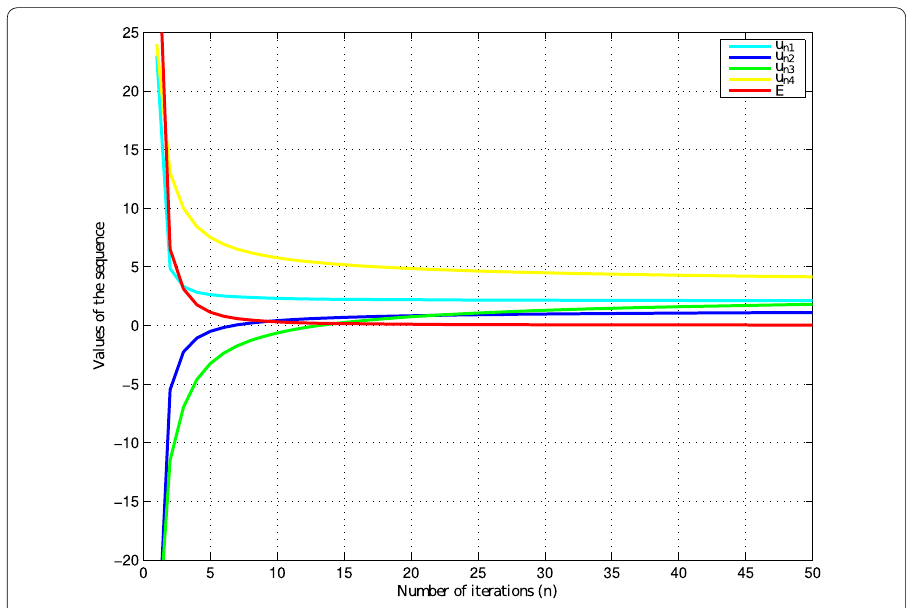
Figure 11 Convergence result of Theorem 3.11 with starting point of Case 7